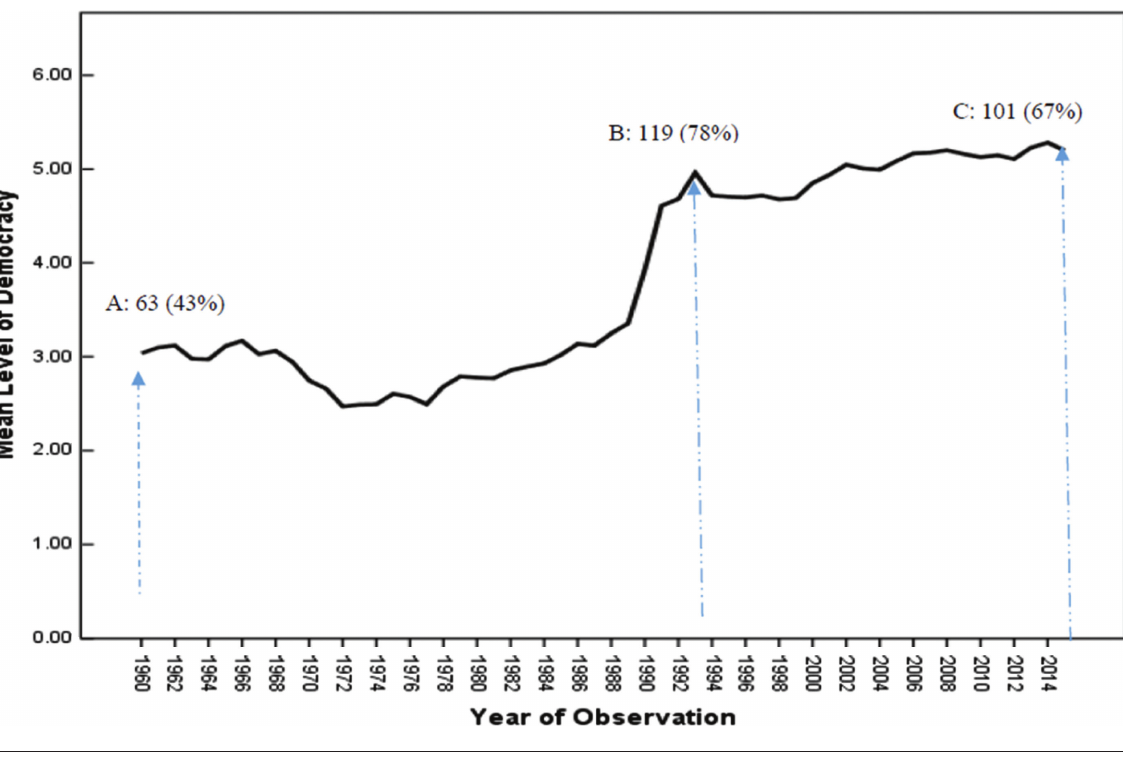
Figure 2. Mean level of democracy across the world, 1960–2016 (Source: data adapted from Marshall and Gurr, 2017, and Wejnert, 2007). Note: A, B, C = number of democracies and ratio of non- democratic countries in the world (percentage); ‘Democratic’ = democracy score larger than 0; ‘Non- democratic’ = score 0. See note for Figure